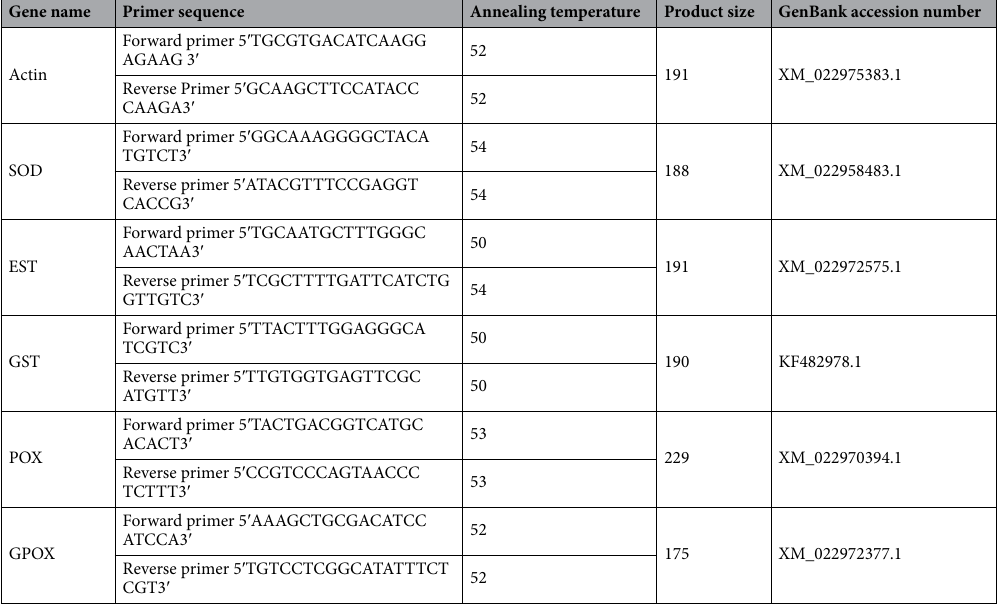
Table 9. Primer sequences used for gene expression analysis using